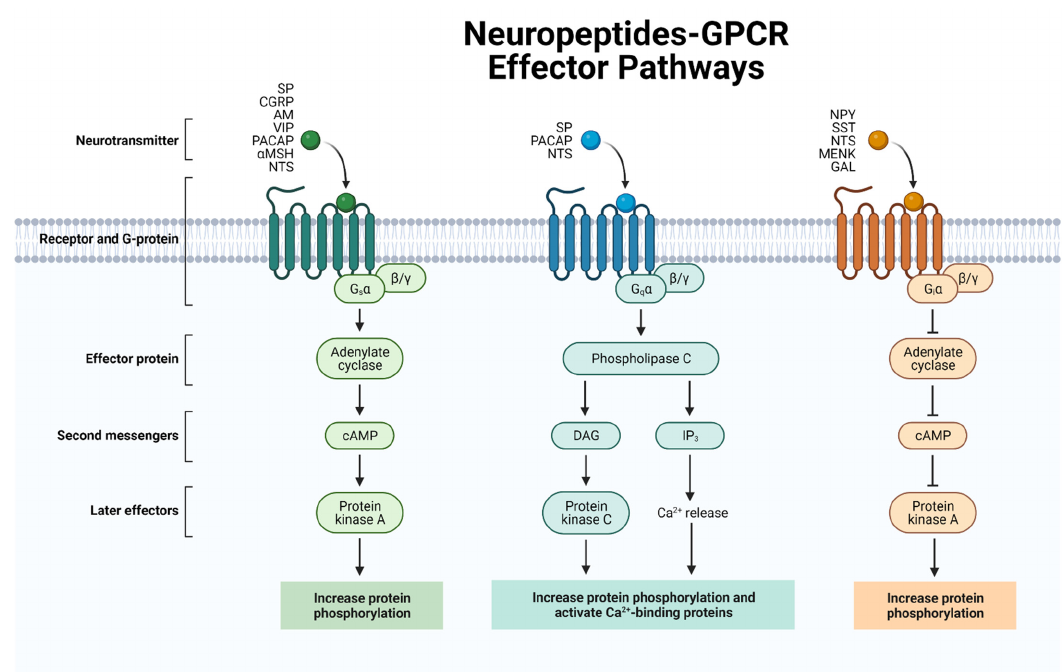
Figure 1. Neuropeptides interact with their G protein-coupled receptors (GPCRs) and the β / γ dimer is separated from the G α subunit classified as Gs, Gq/11, or Gi/o, which transduce the signal intra- cellularly via effector proteins. Adapted from “GPCR Effector Pathways”, by BioRender.com ac- cessed on 26/07/2022. Retrieved from https://app.biorender.com/biorender-templates accessed